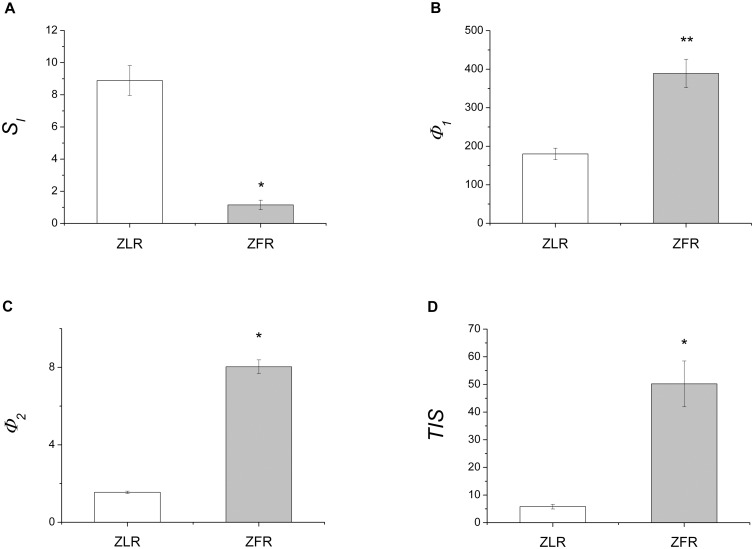
IVGTT-based mean (±SE) values of model predicted: whole-body insulin sensitivity (S
I, panel A); first-phase β-cell responsiveness to glucose stimulus (Φ
1, panel B); second-phase β-cell responsiveness to glucose stimulus (Φ
2, panel C) and total insulin secretion, for unit of distribution volume (TIS, panel D) in ZLR (open bar) and ZFR (shaded bar) groups.Measure units are: 10-4·dL·kg-1·min-1/(μU·mL-1) for S
I; (pmol/L C-peptide)/(mmol/L glucose) for Φ
1; 10-1·min-2·(pmol/L C-peptide)/(mmol/L glucose) for Φ
2; and 103·pmol/L for TIS. * p<0.001 and ** p<0.05 in comparing ZFR and ZLR groups.